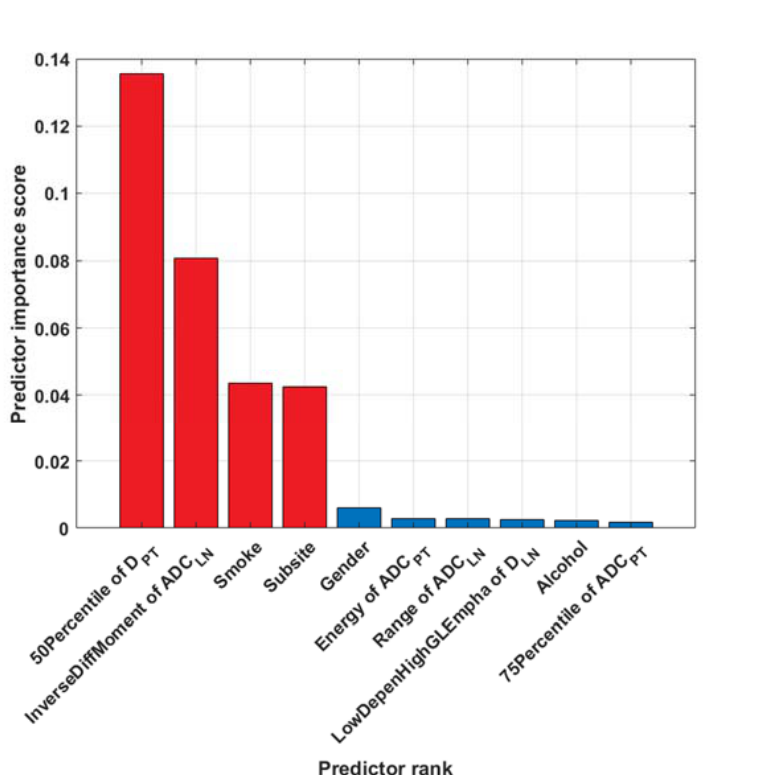
Figure 2. Selection of the most relevant features and the corresponding predictor ranks obtained from the Minimum Redundancy Maximum Relevance (MRMR) algorithm.